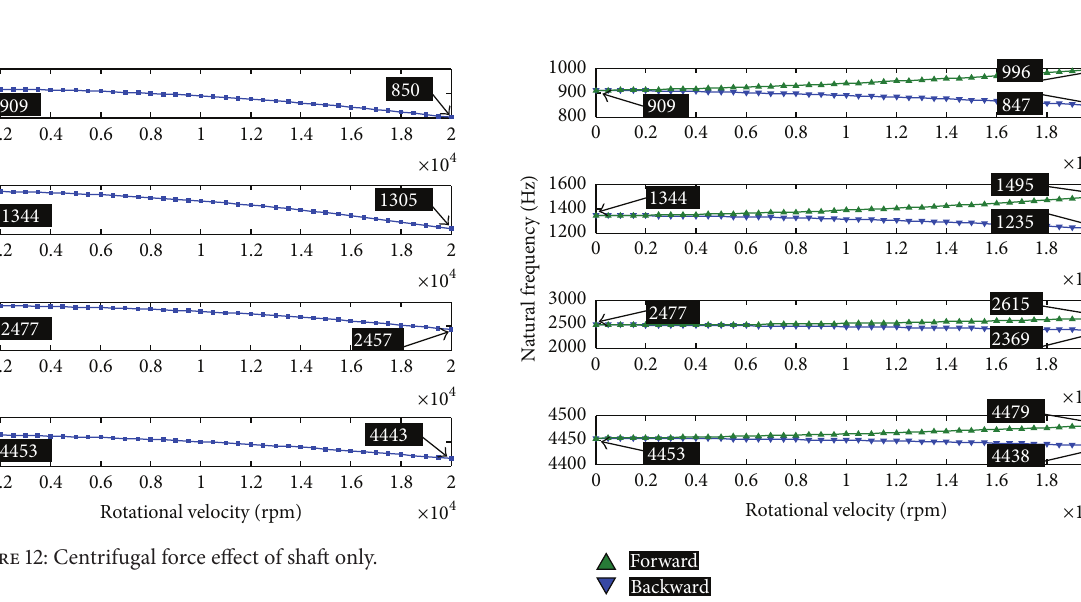
Figure 13: Gyroscopic moment effect of shaft only.